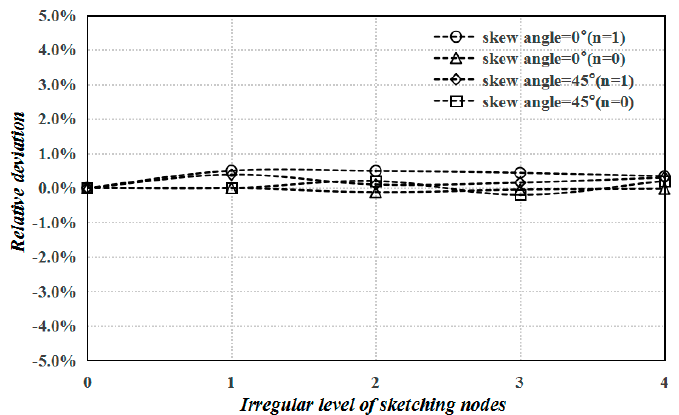
Figure 10. The relative deviation, based on the numerical solution of the present method with a regular cloud of points versus various irregular levels of sketching nodes.